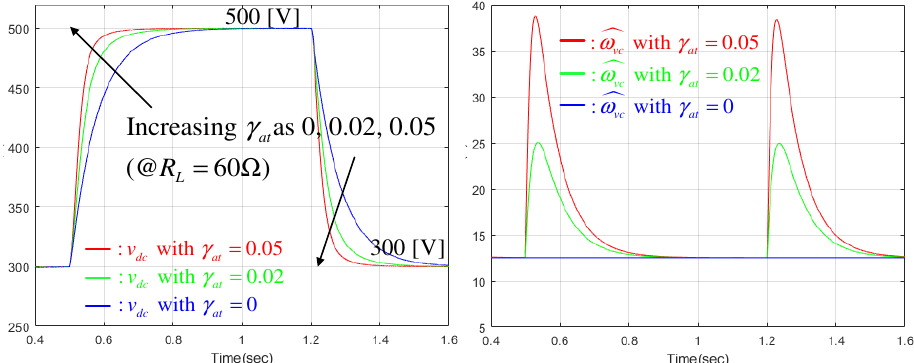
Figure 10. DC-link voltage tracking performance improvement tendency as increasing γ at =